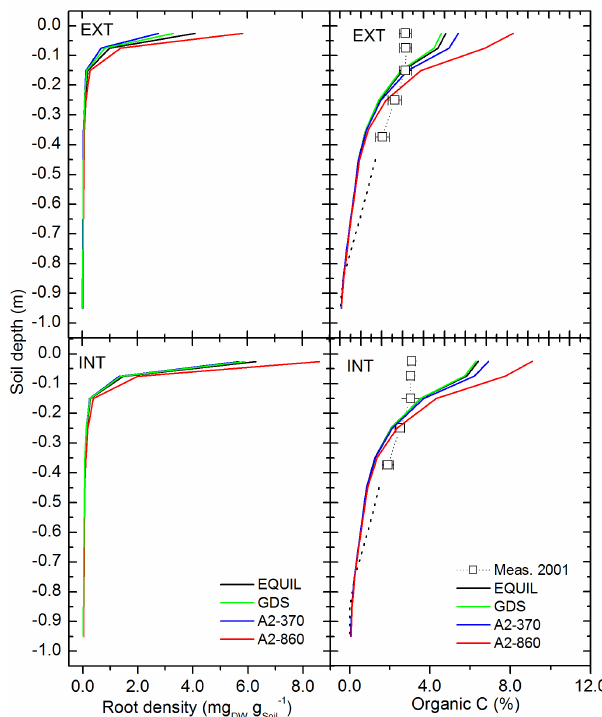
Fig. 6. Simulated root density (left) and soil carbon (right) for EXT (upper pane) and INT (lower pane) in 2001 and 2100 under differ- ent climate and management scenarios. Measurements in 2001 are given ±